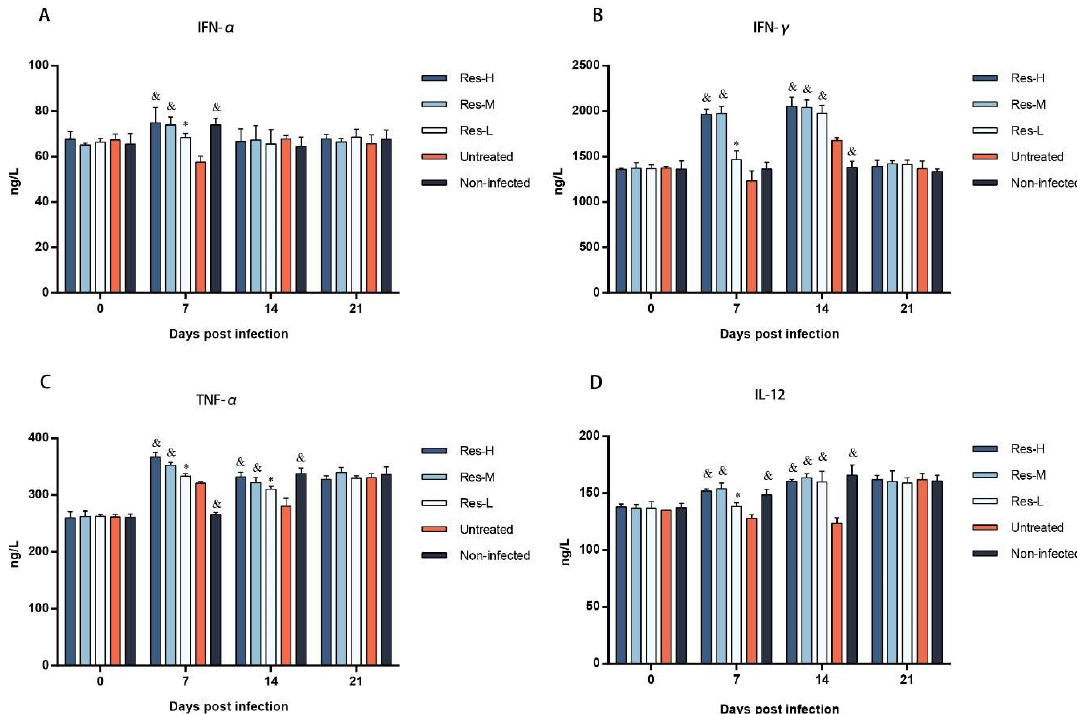
Figure 5. The concentrations of IFN-α ( A ), IFN-γ ( B ), TNF- α ( C ) and IL-12 ( D ) in serum obtained from test piglets. Four cytokines in the serum of the piglets were assayed at 0, 7, 14 and 21 dpi (at each selected time point, all of the living piglets were tested, n ≥ 3 in each group). Correlation analyses were evaluated by Pearson r2, ns: p > 0.05, * p < 0.05 and & p < 0.001 vs. untreated group.